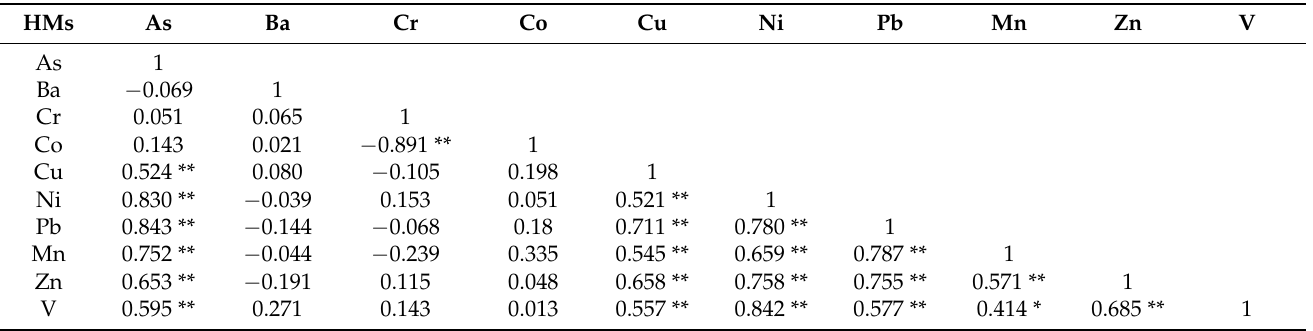
Table 2. Spearman correlation of 10 HMs in sediments of the Mianyang section of the Fujiang